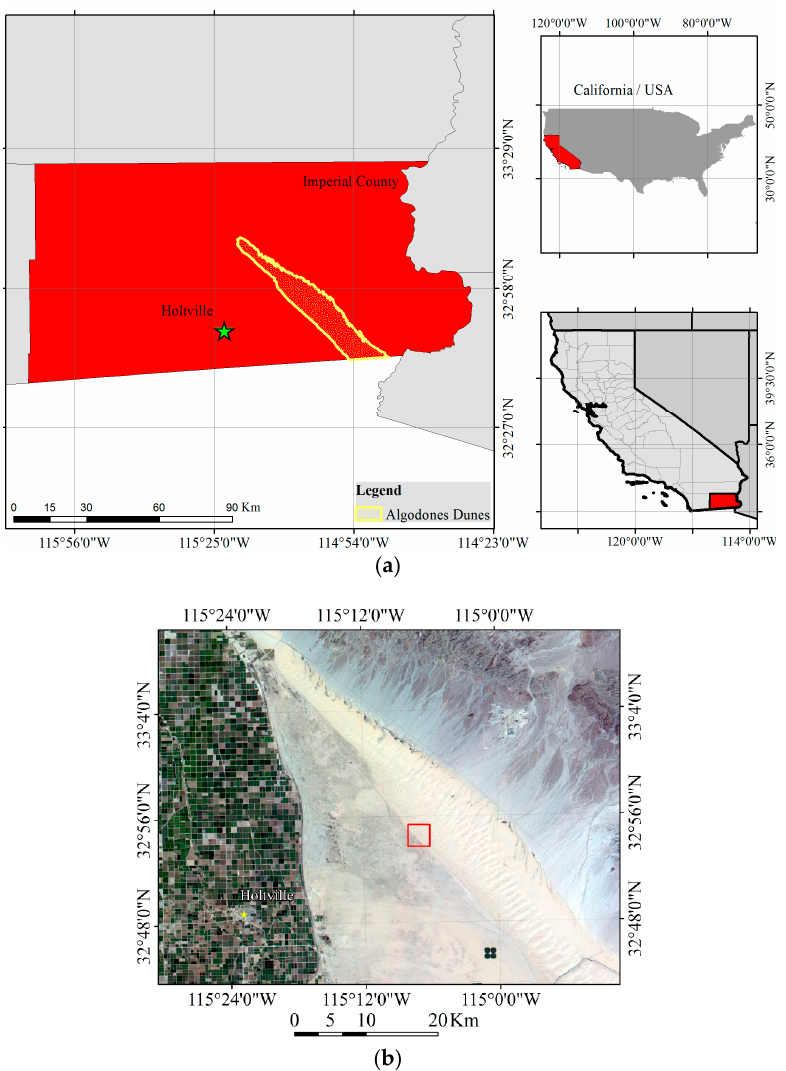
Figure 2. ( a ) Algodones Dunes location; and ( b ) MUX/CBERS-4 image from study area. The red box indicates the location of the field campaign surface.